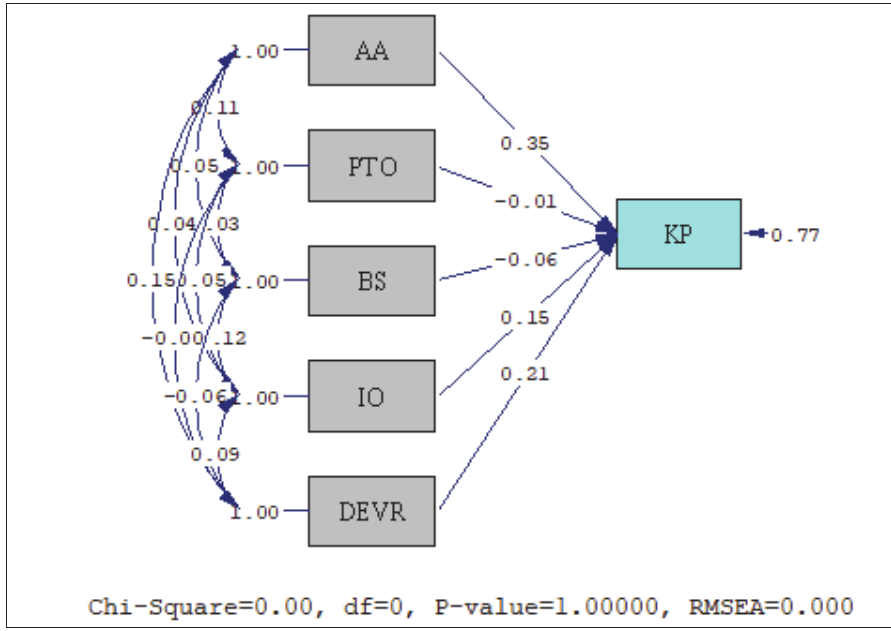
Fig. 3. The Result of Estimated Path